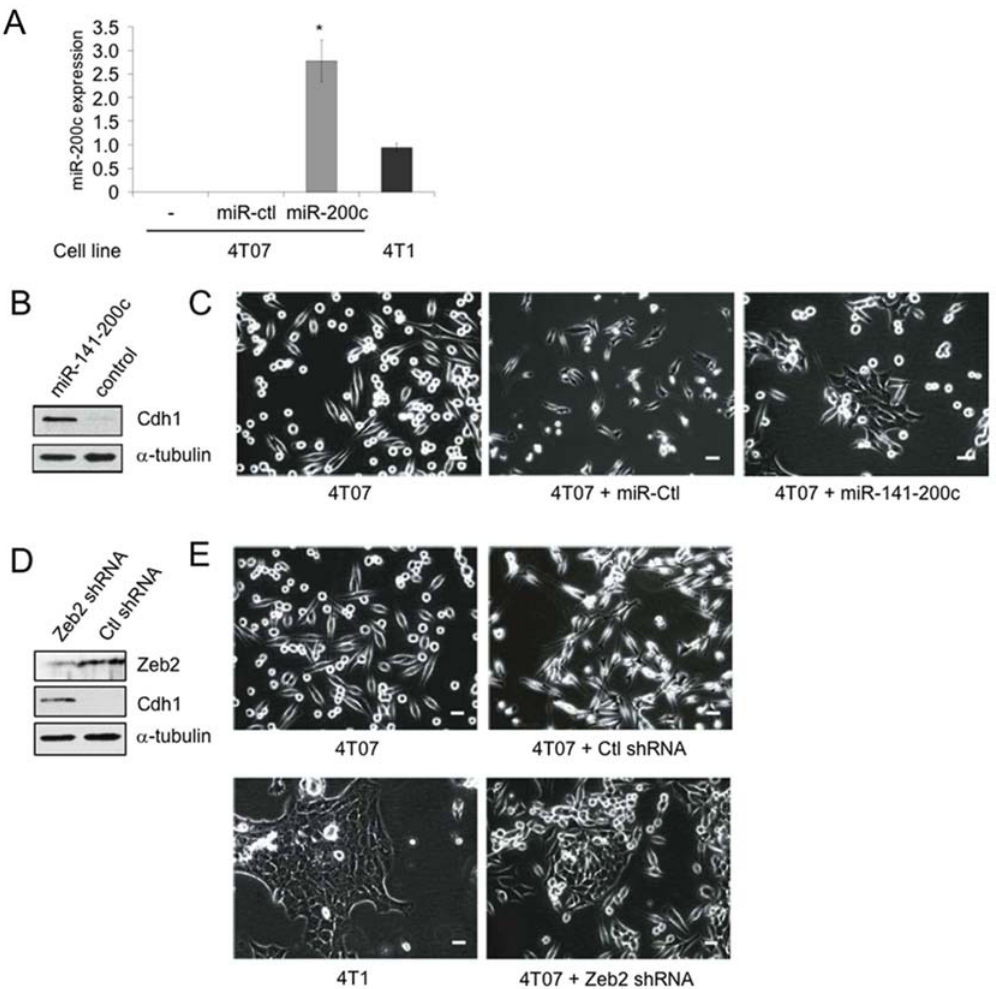
Figure 5. Stable miR-141-200c over-expression or Zeb2 silencing in 4TO7 cells promoted adoption of an epithelial-like morphology. (A) miR-200c expression is increased in 4TO7 cells stably expressing the miR-141-200c cluster from a retroviral vector. miR-200c levels, normalized to U6 snRNA expression, are shown relative to expression in 4T1 cells. Mean and standard deviation of 3 independent experiments are shown (*, p=0.02, relative to 4T1 cells). (B) Stable over-expression of the miR-141-200c cluster leads to an increase in E-cadherin expression, as measured by immunoblot relative to a -tubulin. (C) The stable miR-141-200c-expressing 4TO7 cells adopt an epithelial morphology compared to the control transfected cells or the parental cells when examined by phase contrast microscopy. 4TO7 cells stably expressing a Zeb2 shRNA had reduced Zeb2 and concomitantly increased E-cadherin protein by immunoblot (D), and altered morphology from a fibroblastic to an epithelial morphology (E). 4T1 cells are shown for comparison. The white bars represent 10 m m.